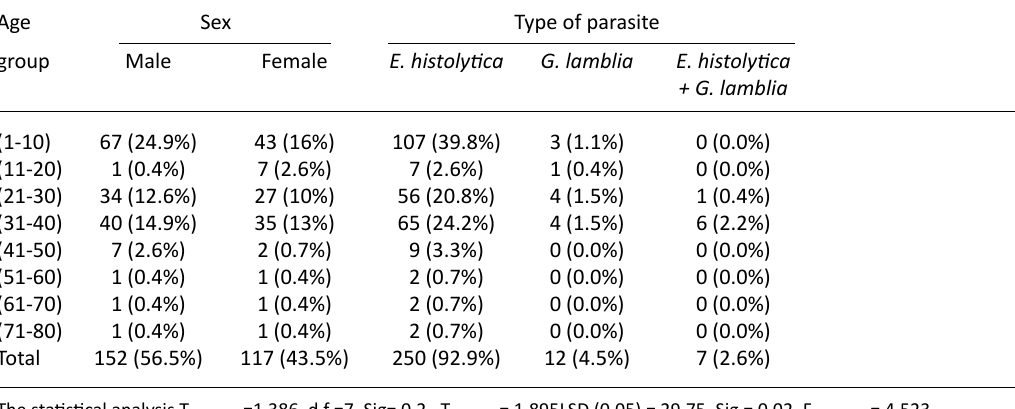
Table 3. Percentage of infection with intestinal parasites according to age groups and six factor in Suq-AL-Shuyukh general